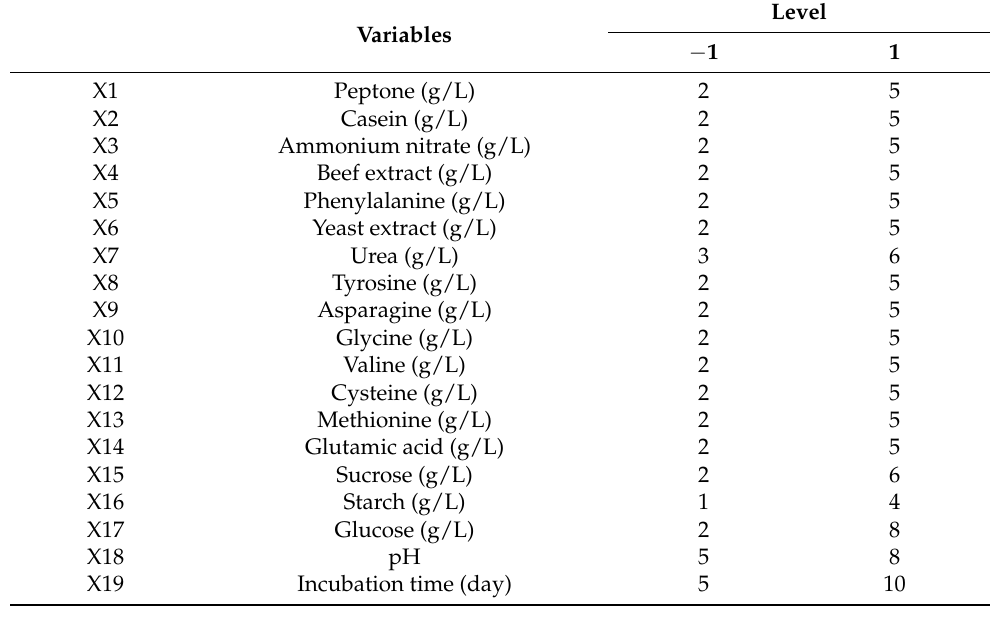
Table 2. Experimental independent variables at two levels for tyrosinase production by Aspergillus terreus and Penicillium copticola using Plackett–Burman design.